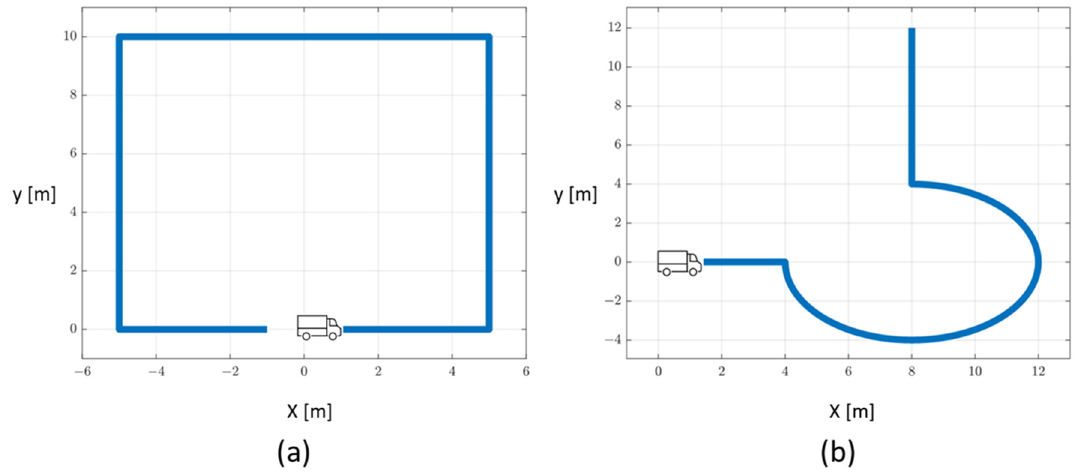
Figure 15. The preset path plans for the lead vehicle: ( a ) square loop and ( b ) roundabout.